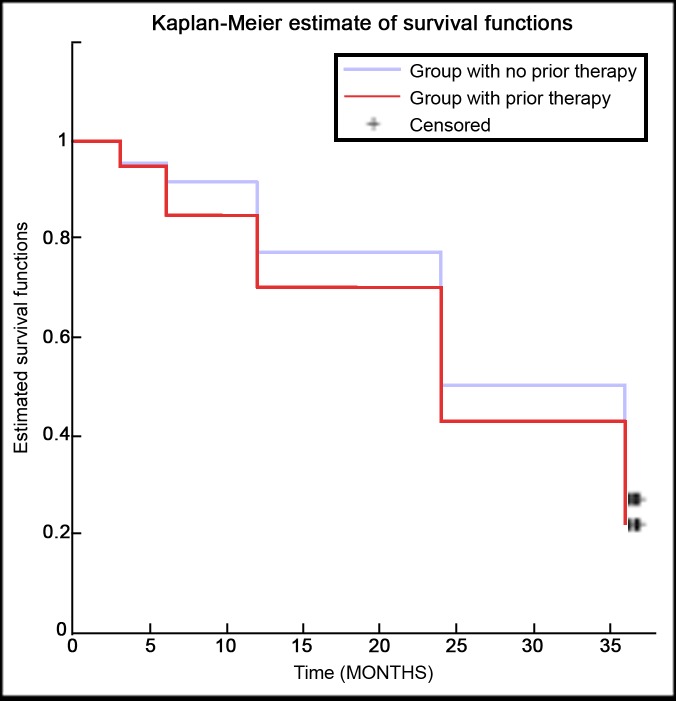
Kaplan-Meier survival curves comparison of ‘naïve’ patients vs. patients with previous treatment.